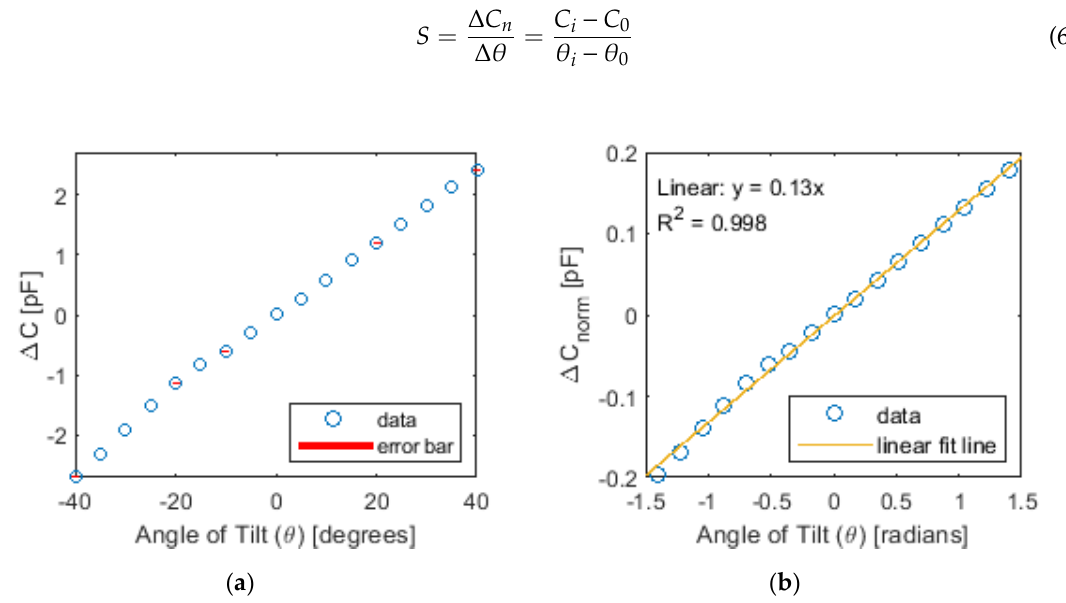
Figure 9. ( a ) The capacitance response of the sensor subjected to different angles of tilt and ( b ) the corresponding normalized change in capacitance data with a linear best-fit line are plotted.